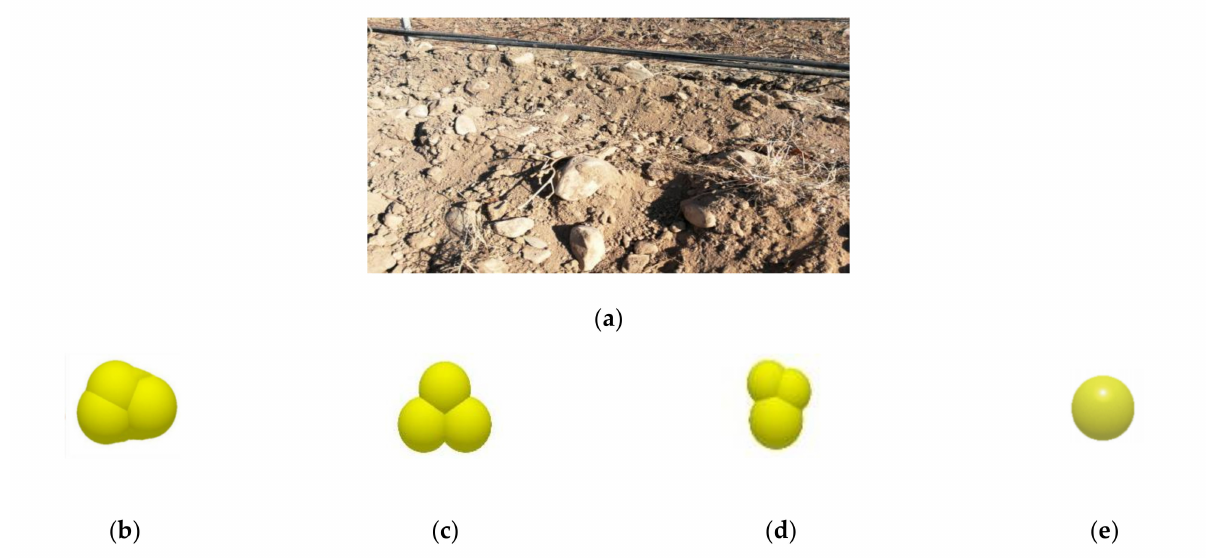
Figure 3. Soil particle models. ( a ) Field soil, ( b ) Ellipsoid, ( c ) 10 mm aggregate, ( d ) 5 mm aggregate, ( e )